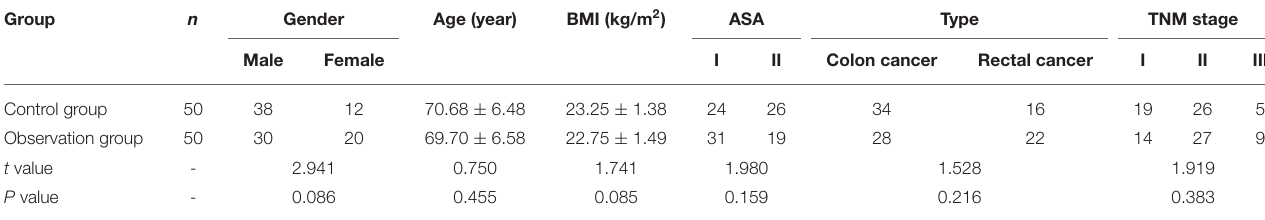
TABLE 1 | Comparison of the general conditions of the two groups of patients ( ¯ x ± s). Group